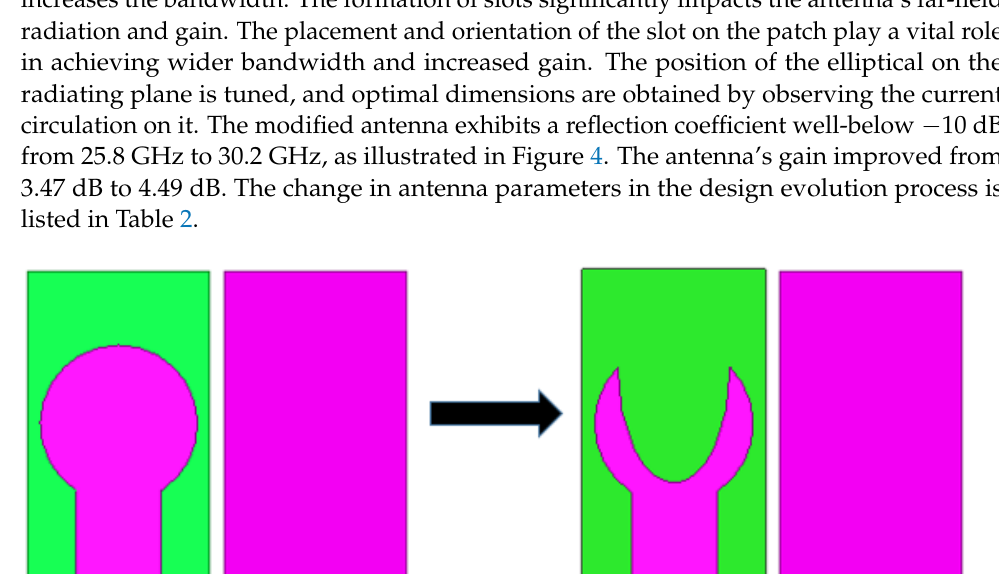
Figure 3. The design development stages of projected antenna ( a ) first stage ( b ) proposed antenna. Table 2. Antenna parameters in the design evolution process.